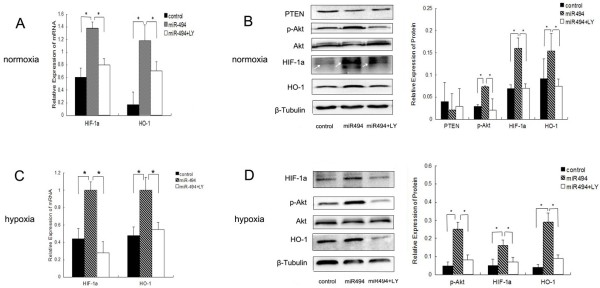
MiR-494 induced HIF-1α and HO-1 expression by activating PI3K/Akt pathway. (A) Cells were transfected with miR-494 mimic or miR-negative control under normoxia as described above. After transfection, cells were treated with or without 30 μM of LY294002 (PI3K inhibitor, block the PI3K/Akt pathway) for 8 hours. mRNA levels of HIF-1α and HO-1 were analyzed by real-time RT-PCR after transfection for 48 hours. (B) The expression of PTEN, p-Akt, Akt, HIF-1α, HO-1 and β-Tubulin were analyzed by western blot after 48 hours for transfection. Left: Western blot analysis for proteins. The signal indicated by white arrow is HIF-1α. Right: Densitometric analysis of the western blot in left. (C-D) Transfected cells were continuously treated with or without 30 μM of LY294002 for 16 hours prior to hypoxia (1% O2, 5% CO2 in a 37°C incubator). Eight hours later, cells were harvested for RNA and protein, real-time RT-PCR (C) and western blot (D. Left: Western blot analysis for proteins. Right: Densitometric analysis using Quantity one software in left) were done. Control indicates miR-negative control. MiR-494 + LY indicates treatment with LY294002 in transfected cells. Data were normalized by the level of β-Tubulin expression except p-Akt in panel B and panel D. The data of p-Akt was normalized by the level of Akt expression. The data were presented as the means ± SD. Columns, mean of three independent experiments; bars, SD; *p < 0.05.